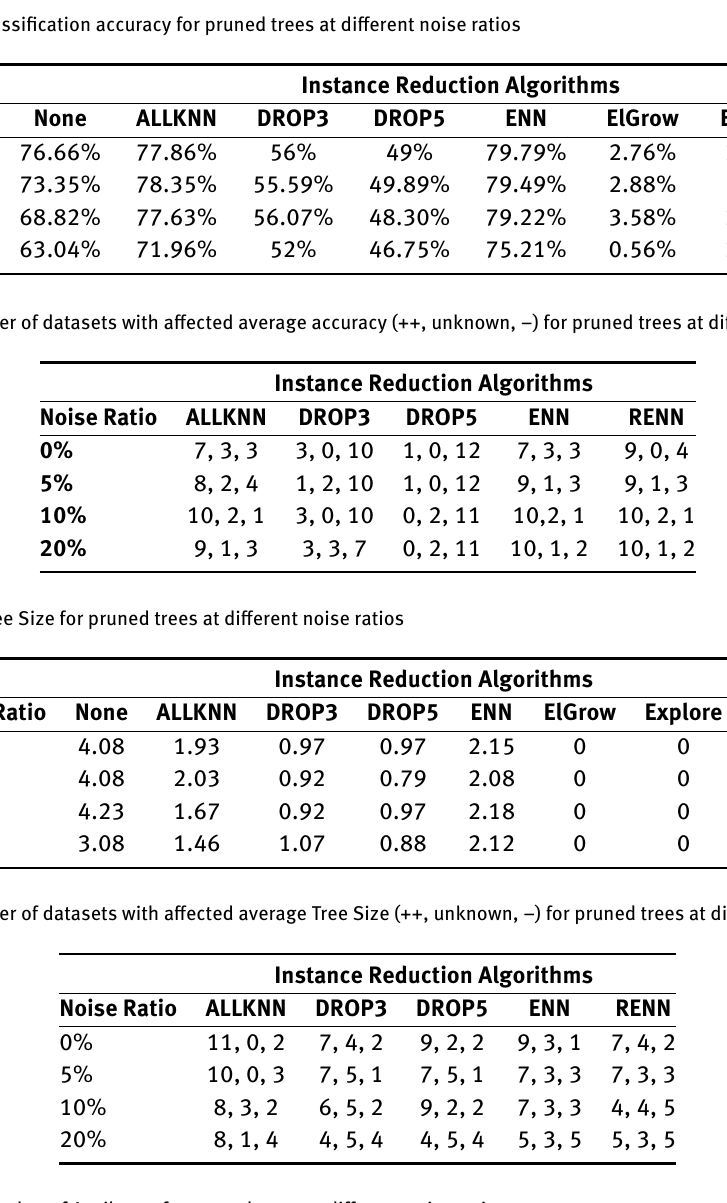
Table 18: Average Number of Attributes for pruned trees at different noise